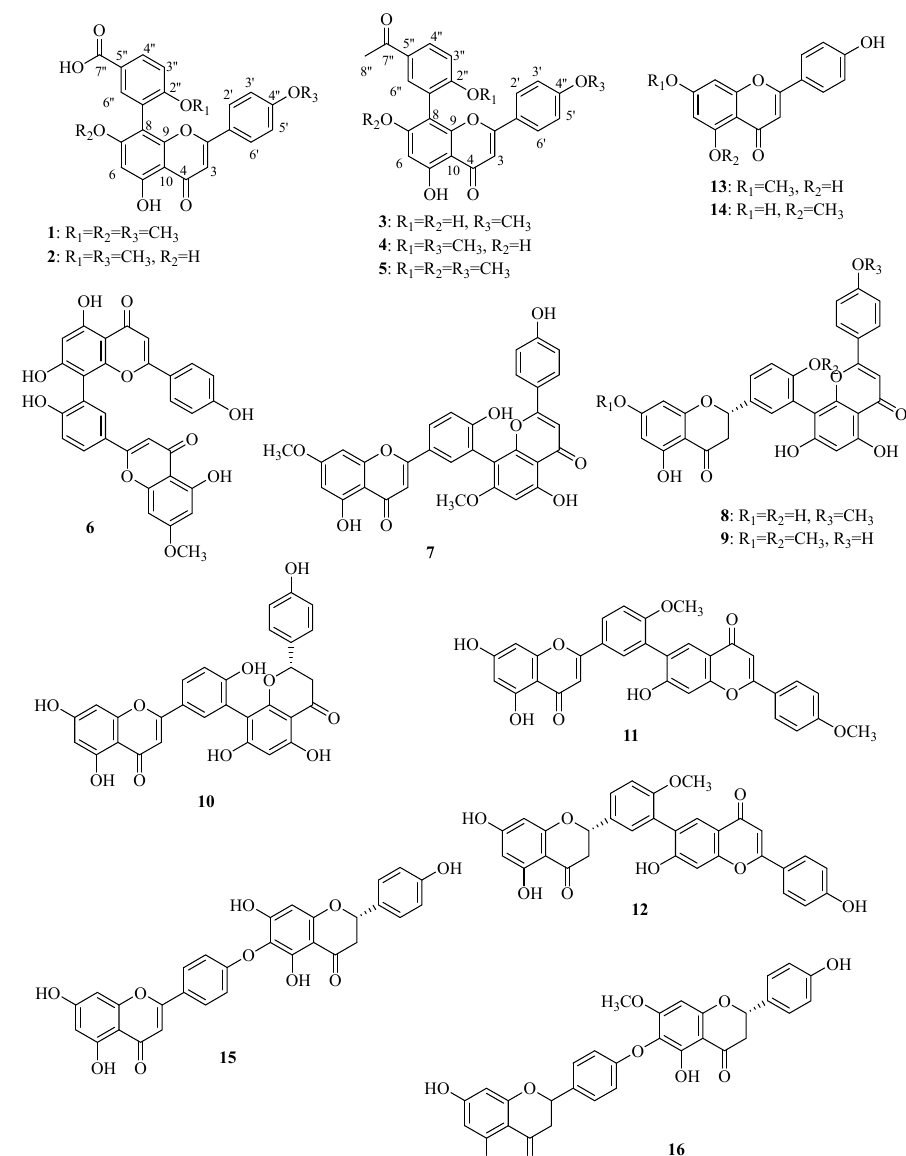
Figure 4. Chemical structures of isolated compounds ( 1 – 16 ) from DCM fraction of S. doederleinii. The three methoxy groups were assigned to be attached to C-7, C-4 (cid:48) , and C-2 (cid:48)(cid:48) , which were determined by HMBC signals from δ H 3.82 to δ C 163.3 (C-7), δ H 3.86 to δ C 164.4 (C-4 (cid:48) ), and δ H 3.77 to δ C 163.1 (C-2 (cid:48)(cid:48) ). Besides the tri-substituted benzene ring (ring D), the remaining signals disclosed that Compound 1 had a flavonoid skeleton. The singlet proton at δ H 6.60 (H-6) suggested that ring A could be substituted either at C-6 or C-8, and the HMBC studies have shown that the 1,2,5-trisubstituted benzene ring (ring D) was linked to C-8 by the correlation from δ H 7.93 to δ C 105.6 (C-8). It was concluded that compound 1 was an apigenin derivative and the chemical structure was determined as 3-(5-hydroxy-7- methoxy-2-(4-methoxyphenyl)-4-oxo-4H-chromen-8-yl)-4-methoxybenzoic acid. Compound 3 was isolated as a yellow amorphous powder. Through HR-ESI-MS (positive ion mode) analysis, a molecular ion peak appeared at m / z 419.1121 [M + H] + (calculated for [M+H] + 419.1125) (Figure S10), indicating a molecular formula of C 24 H 18 O 7 for 3 , which was per the 1 H NMR and 13 C NMR spectroscopic data (Table 3, Figures S11 and S12). The 1 H NMR data of 3 displayed the presence of a 1,2,5-trisubstituted benzene moiety (ring D) at δ H 8.01 (1H, dd, J = 8.4, 2.3 Hz, H-4 (cid:48)(cid:48) ), 7.99 (1H, d, J = 2.2 Hz, H-6 (cid:48)(cid:48)